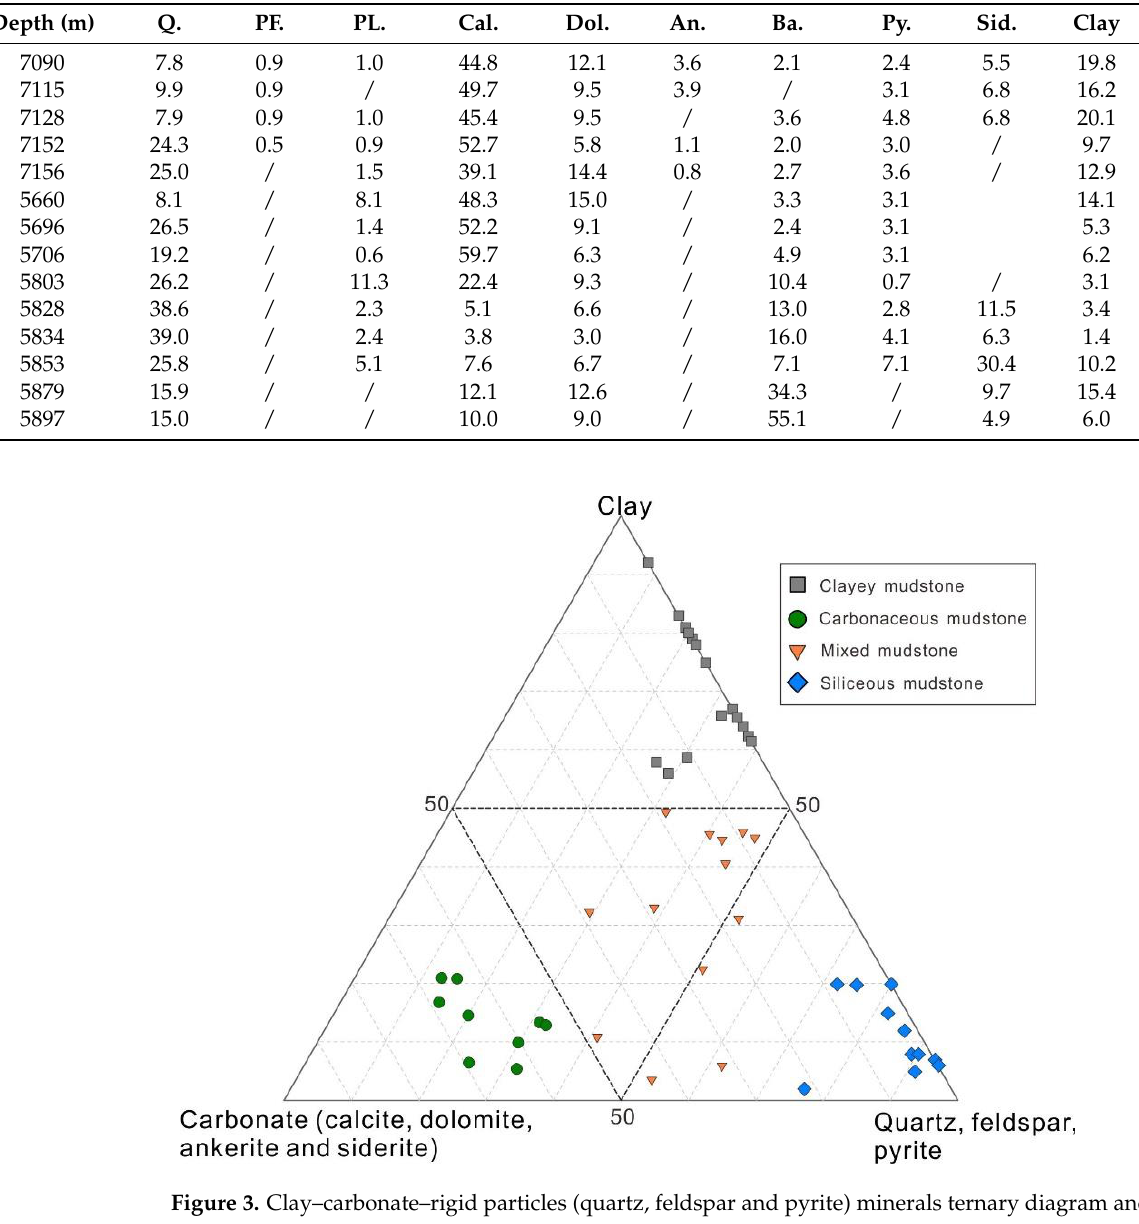
Table 1. The mineral composition (%) of the Longtan Formation shale in the eastern Sichuan Basin. (In this table, Q. = quartz, PF. = potash feldspar, PL. = plagioclase, Cal. = calcite, Dol. = dolomite, An. = anatase, Ba. = barite, Py. = pyrite, Sid. = siderite).